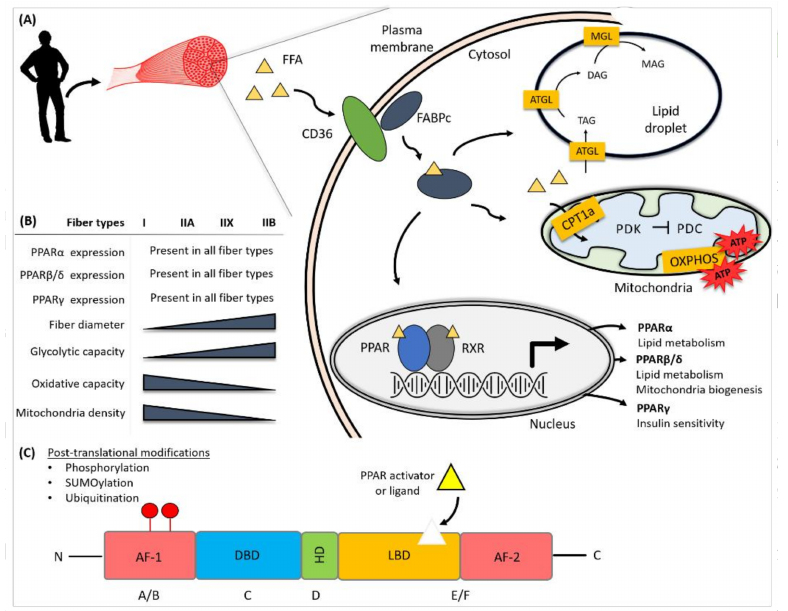
Figure 1. Schematic diagram of skeletal muscle fiber and its fatty acid handling. ( A ) The fate of free fatty acid (FFA) in skeletal muscle. FFA uptake is mediated by receptors, such as CD36, at the plasma membrane. Within the cell, FFA is transported throughout the cellular compartments, via the lipid transporter, FABPc. FFAs can either be targeted to the lipid droplet for storage, translocated to the mitochondria for fatty acid oxidation, or serve as a ligand for peroxisome proliferator-activated receptors (PPARs) within the nucleus. In the skeletal muscle, PPAR α and PPAR β / δ are mainly involved in lipid metabolism regulation. PPAR β / δ is also involved in regulating mitochondria biogenesis while PPAR γ is involved in skeletal muscle insulin sensitivity and glucose regulation. ( B ) The spectrum of skeletal muscle fiber type characteristics. All three of the PPAR isotypes are expressed regardless of the fiber types. Slow-twitch type I fibers are smaller in fiber diameter, with high oxidative capacity and mitochondria density, while fast-twitch type II fibers have a range in their fiber diameters, typically higher glycolytic capacity with lower mitochondria density, and oxidative capacity in comparison to type I fibers. ( C ) Schematic diagram of PPAR protein structure. PPARs are regulated by post-translational modifications, such as phosphorylation, SUMOylation, and ubiquitination in the presence or absence of ligand. Activation function, AF; DNA-binding domain, DBD; Hinge domain, HD; ligand binding domain,